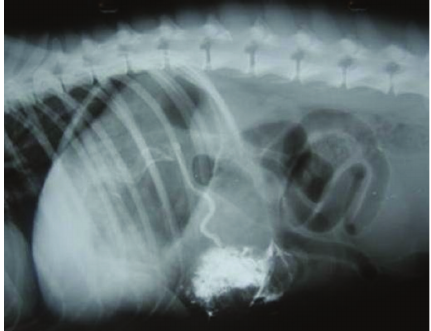
Figure 10: Ultrasound-guided percutaneous normal-appearing splenic portogram demonstrating splenic vein normally draining into portal vein with hepatic contrast opacification in 3-year-old male Labrador Retriever